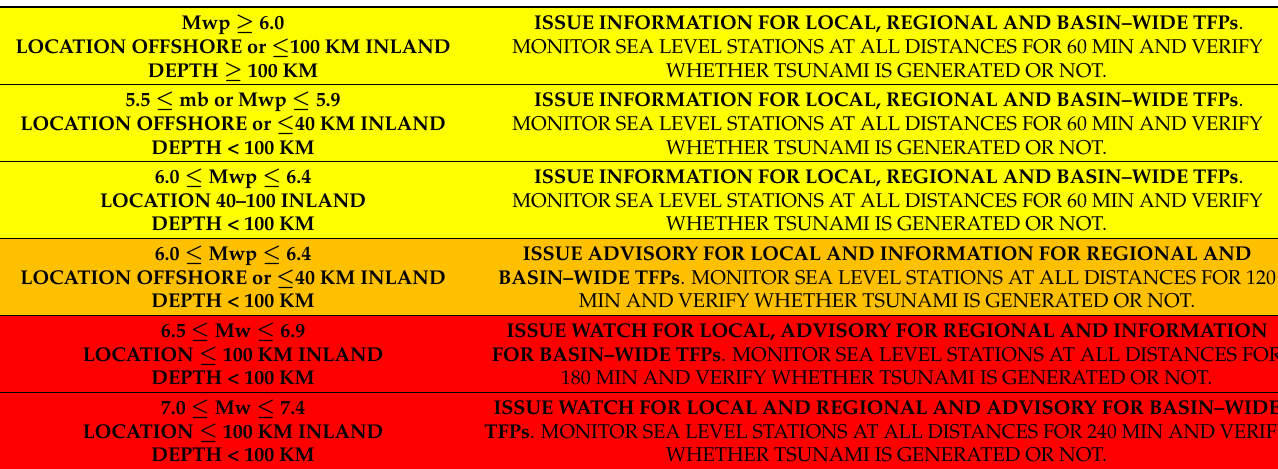
Figure 4. Decision flow–chart for KOERI–TSP. Table 1. Simplified SOP for the KOERI–TSP duty officer.